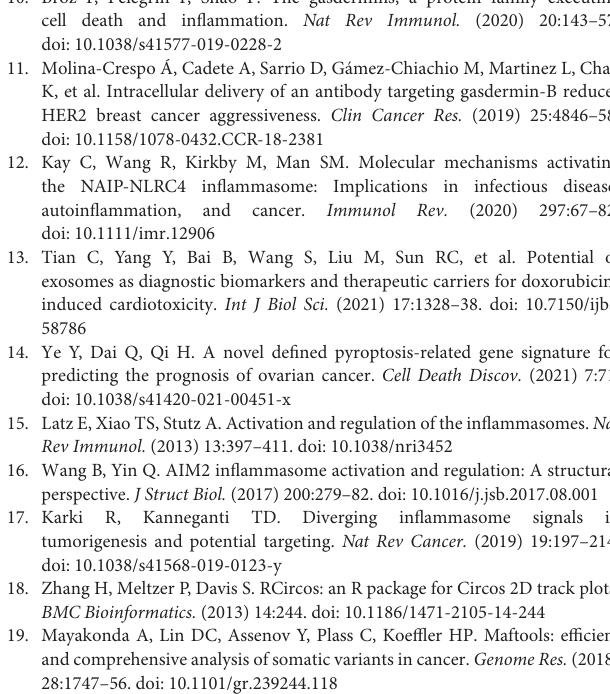
Supplementary Table 1 | Clinical information of 1,082 breast cancer patients. Supplementary Table 2 | The gene sets of cancer-related